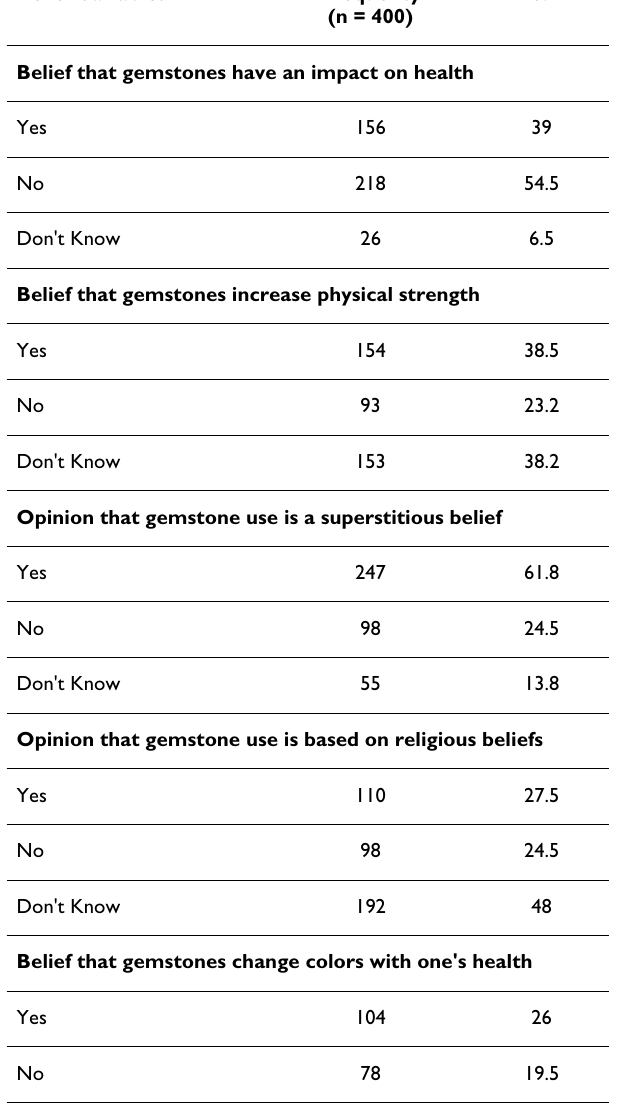
Table 3: Belief Variables Belief